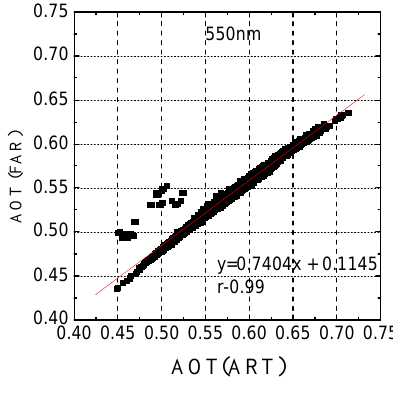
Fig. 13. The same as in Fig. 12, except for the wavelength of